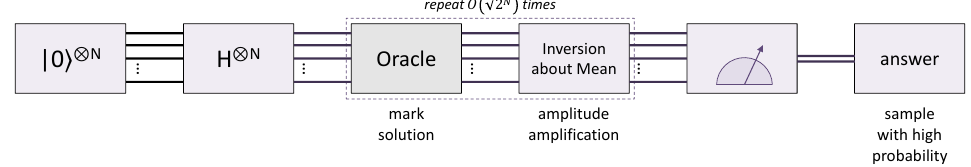
Figure 3. Grover’s search